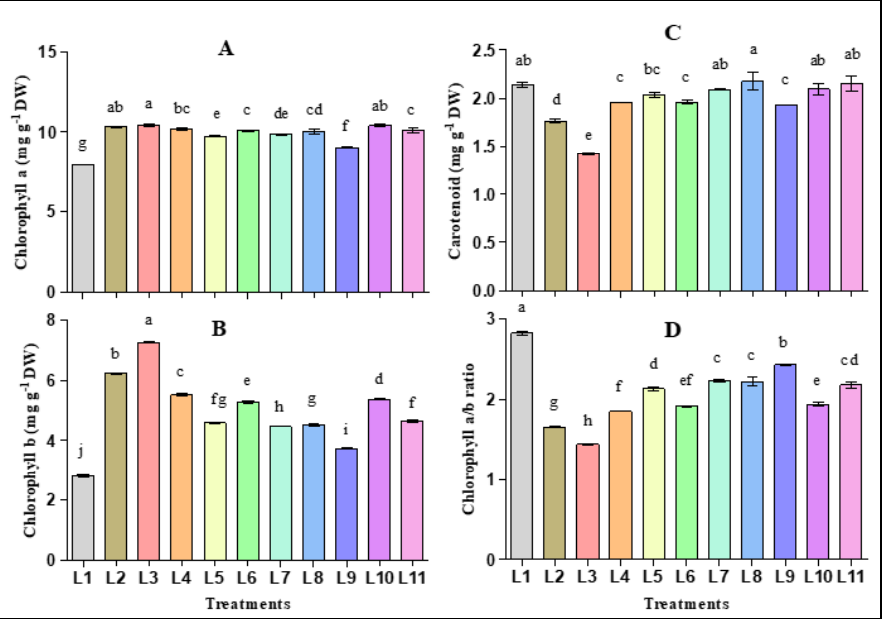
Figure 4. Effect of 20 days exposure to different LED spectra on chlorophyll a ( A ), chlorophyll b ( B ), carotenoid ( C ), and chlorophyll a / b ratio ( D ) of hemp seedlings. Here and subsequent figures: L1, Natural light; L2, White; L3, R 8 :B 2 ; L4, R 7 :B 2 :G 1 ; L5, R 7 :B 2 :FR 1 ; L6, R 6 :B 2 :G 1 :FR 1 ; L7, R 5 :B 2 :W 2 :FR 1 ; L8, R 5 :B 2 :G 1 :FR 1 :UV 1 ; L9, R 6 :B 2 :FR 1 :UV 1 ; L10, R 4 :B 2 :W 2 :FR 1 :UV 1 ; L11, R 2 :B 2 :G 2 :W 2 :FR 1 :UV 1 . All treatments used a photosynthetic photon flux density of 300 µmol m −2 s −1 . Column height indicates the mean, vertical bars indicate the standard error of the mean (n = 4), and different letters indicate significant differences at p < 0.05.